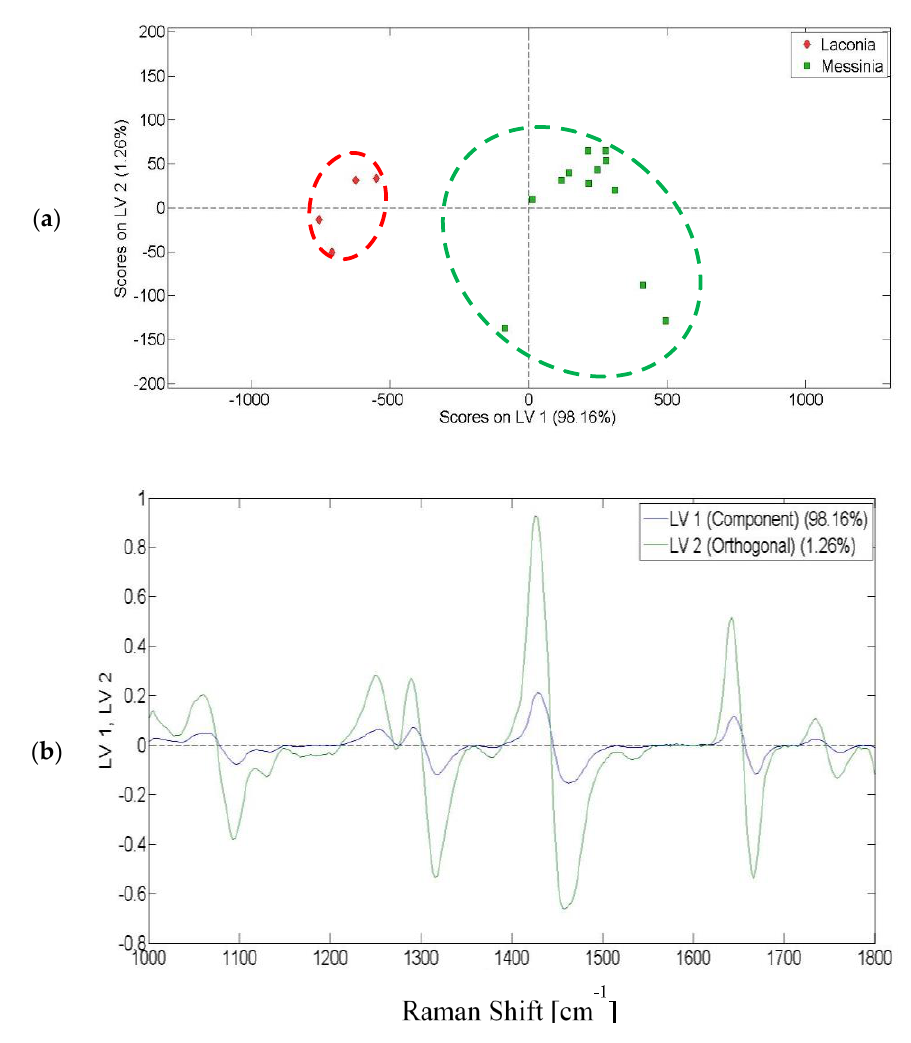
Figure 6. Classification of olive oils: ( a ) score plot for the discrimination of the olive oils from Peloponnese using Raman spectroscopy; ( b ) loading plot based on Raman spectra.